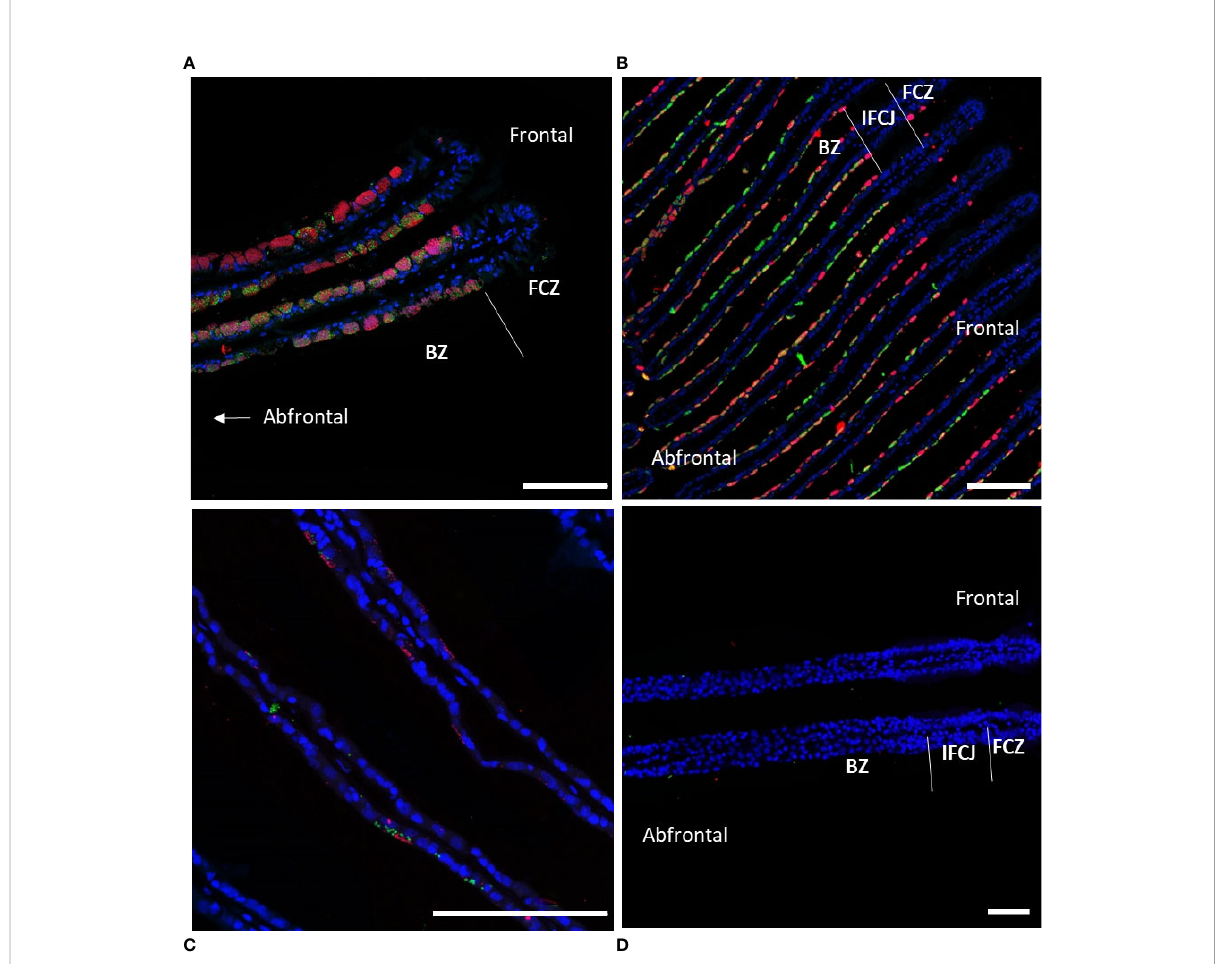
FIGURE 2 Fluorescence in situ hybridization performed on gill lamellae cross-sections showing decreasing symbiont densities during starvation. Host nuclei stained by DAPI in blue, Methane-Oxidizing symbiont (MOX) in green, and Sul fi de-Oxidizing symbiont (SOX) in red. (A) Immediately after collection (t=0), MOX and SOX fi ll almost the entire cytoplasm of all bacteriocytes; (B) after 8 days of starvation MOX and SOX are restricted to the cytoplasmic apex of the bacteriocytes; (C) after 16 days, MOX and SOX are only present sporadically in the apex of some bacteriocytes; (D) after 61 days of starvation MOX and SOX have almost totally disappeared from the gill epidermis. Abbreviations: BZ bacteriocyte zone, FCZ frontal ciliated zone, IFCJ inter- fi lamentary ciliated junctions. The abfrontal zones correspond to the inner side of the gill lamellae, opposite to the frontal ciliated zones, the latter corresponding to the external sides of the gill lamellae facing the inhalant sea-water current (see Figure 1A in Piquet et al., 2020, for a three-dimensional scheme). All Scale bars represents 100